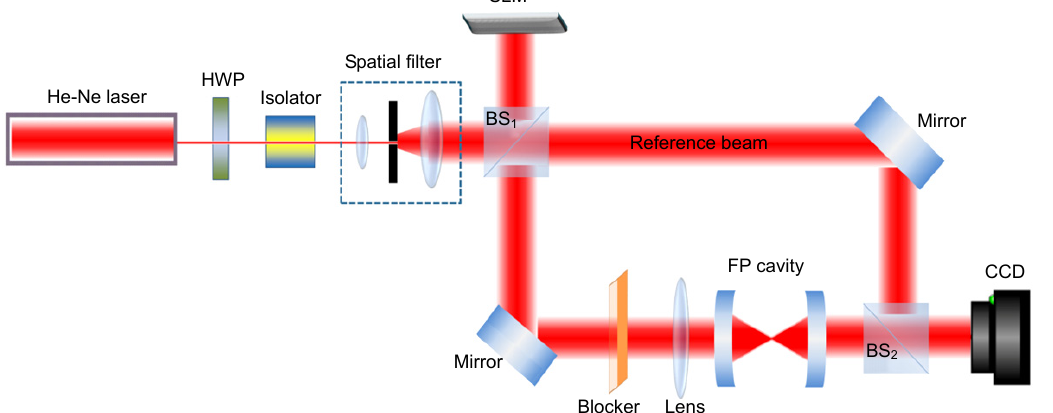
Fig. 2 | Illustration of the experimental setup . A linearly polarized beam from a He-Ne laser propagated through a half-wave plate (HWP) and an optical isolator before being spatially filtered. The filtered beam then traveled through a 50/50 beam splitter (BS 1 ), which provided a normal incidence beam onto the spatial light modulator and a reference Gaussian beam for generating the interference patterns. The OV beam was reflected from the first diffraction order of the SLM and mode-matched to the FP cavity using a thin lens with a focal length of 250 mm. A blocking-plate was then used to precisely control the blocking of the incident beam of the FP cavity. The transmitted light was monitored using either a CCD camera or a